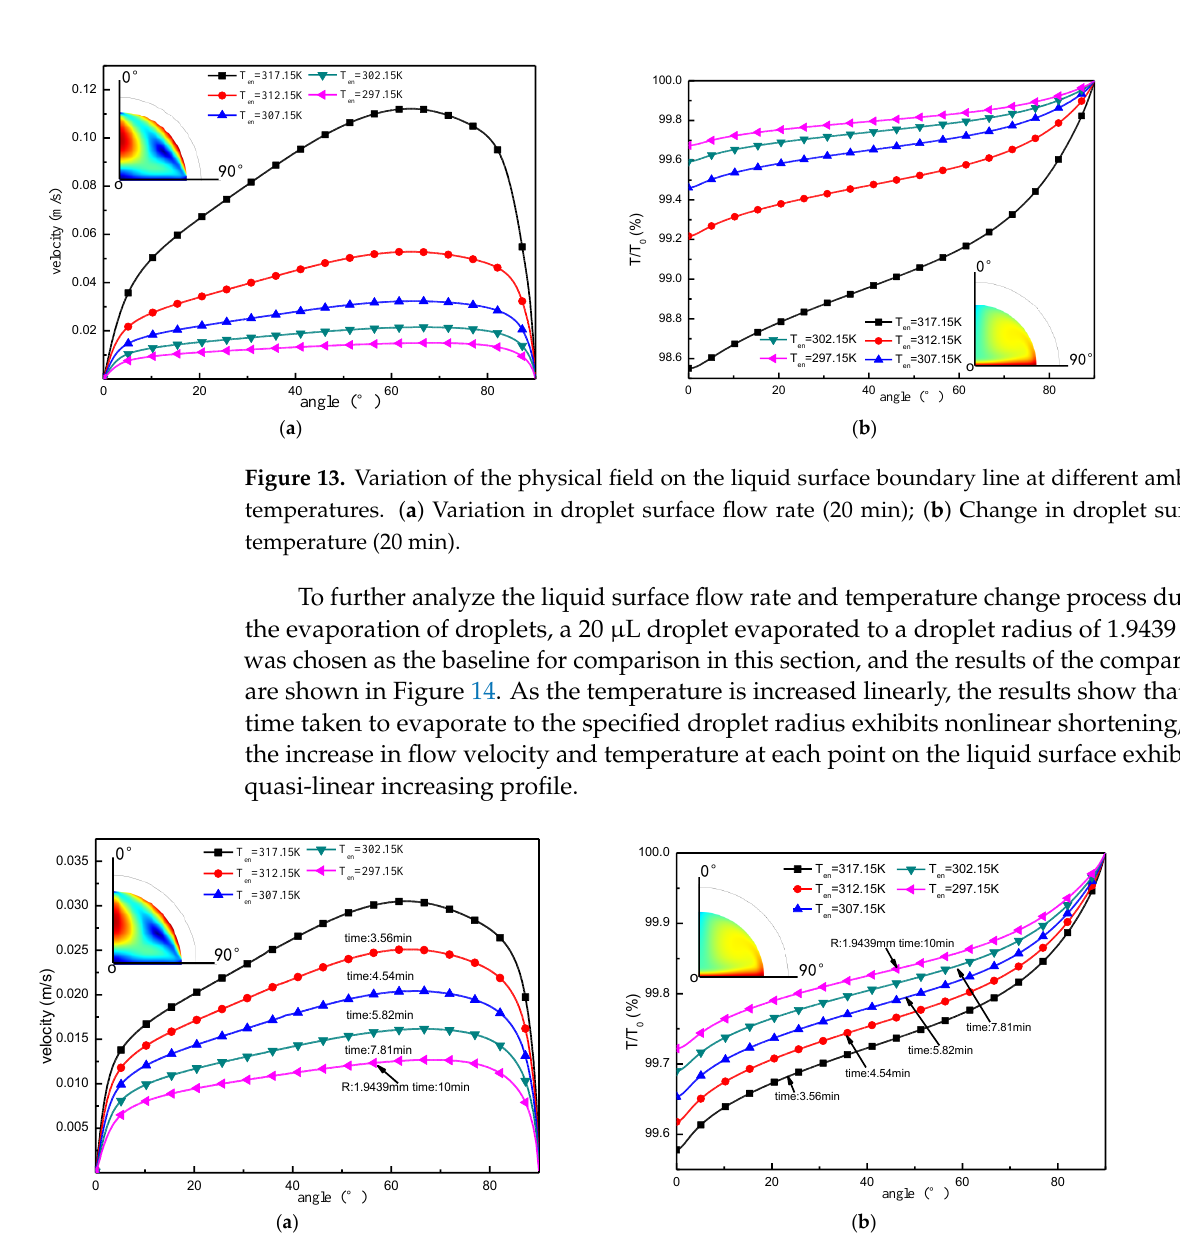
11 of 14 Figure 12. Evaporation at each moment for different initial droplet radii. 3.3. Effect of Ambient Temperature on Droplet Evaporation One of the main factors affecting evaporation of liquids is the ambient temperature, whereas according to Equations (6 – 11), the density and surface tension of the droplet are related to the ambient temperature. To analyze the effect of the ambient temperature on the temperature and velocity distribution inside the droplet due to the Marangoni effect, in this section, the ambient temperatures of 297.15 K, 302.15 K, 307.15 K, 312.15 K, and, respectively, 317.15 K were compared to the changes in the flow velocity and temperature of the liquid surface during the evaporation of the 20 μL droplets, as shown in Figure 12. This shows that increasing the ambient temperature strengthens the Marangoni flow, and the surface liquid flow velocity increases. The increase in flow velocity is nonlinearly re- lated to ambient temperature; the higher the temperature, the larger the increase in flow. So that the difference in the change in liquid surface temperature at different ambient